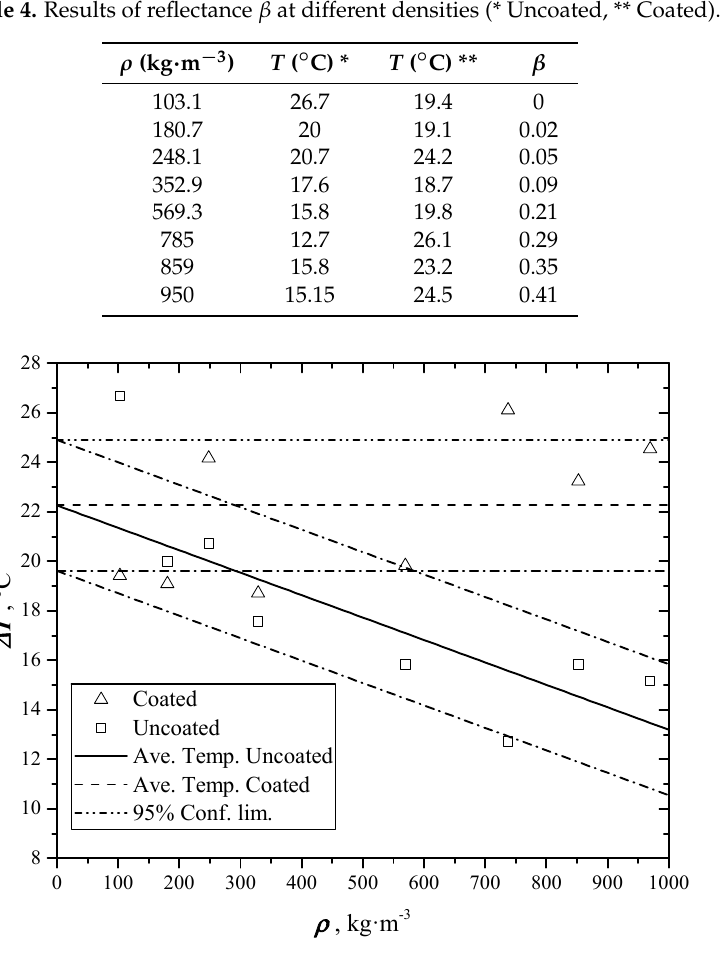
Figure 10 . Asymptotic temperature increases during thermal diffusivity tests, for coated and uncoated samples, as a function of density.